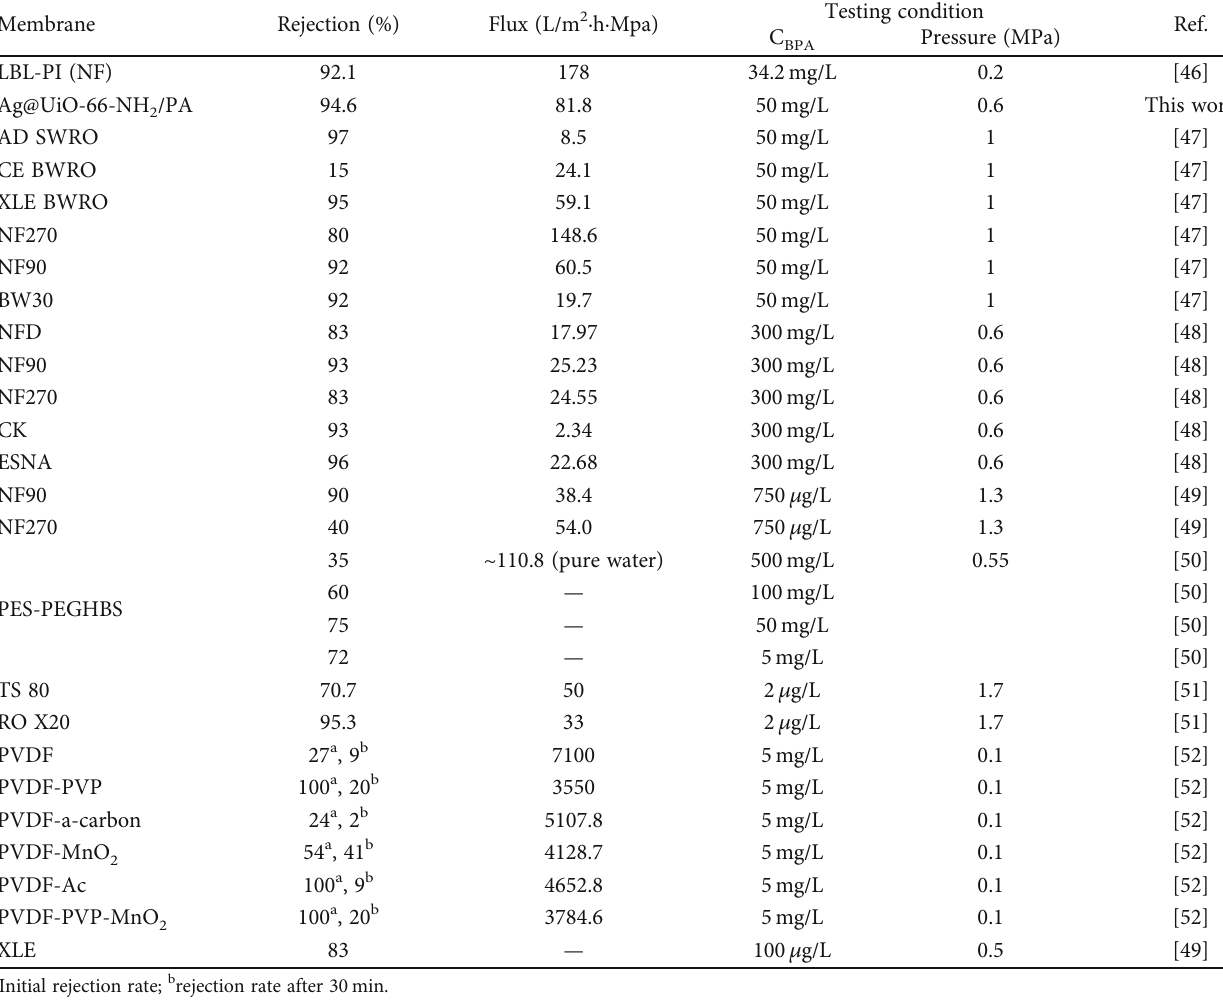
Table 1: Comparison of solution permeability and BPA rejection of various membranes.